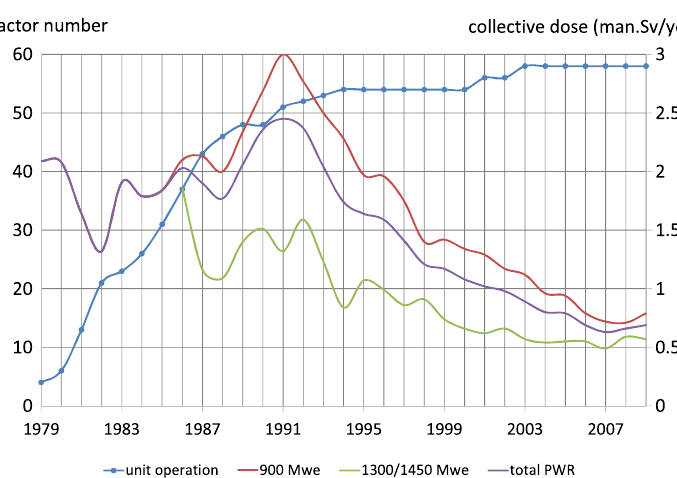
Fig. 6. Average annual collective dose by reactor type in the French fl eet (from [13]).